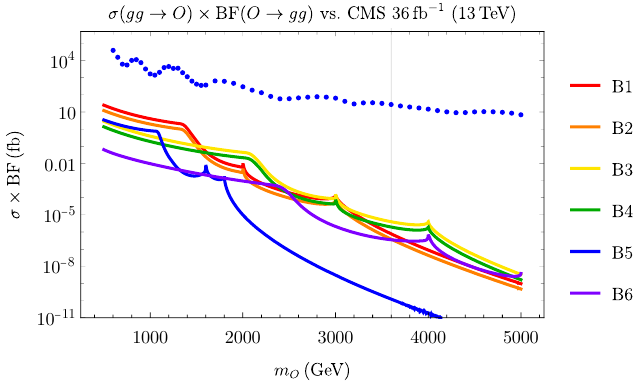
Figure 11. Cross sections in benchmarks B1{B5 of single sgluon production with subsequent decay to gluons compared to exclusion bound from CMS 36 fb (cid:0) 1 (13 TeV) dijet resonance search for color-octet scalars assuming (cid:27) ( O ) = (cid:27) e(cid:11) ( gg ! O ) (6.1) and BF( O ! gg ) = 1. Exclusion is denoted by blue dots. Gray line marks CMS lower limit m O (cid:21) 3.6